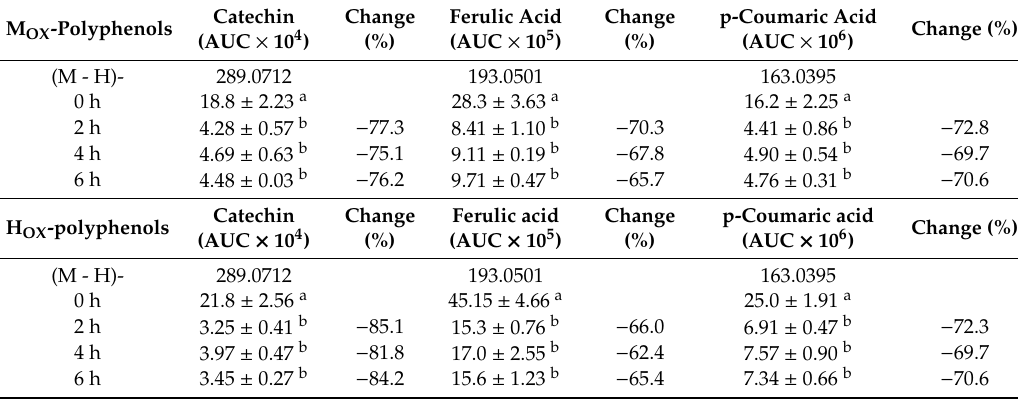
Table 2. E ff ects of the gastric in vitro digestion of the cold-pressed grape seed oils on single polyphenols, measured by high-resolution LC-MS ( < 5 ppm) 1 as area under the curve (AUC).